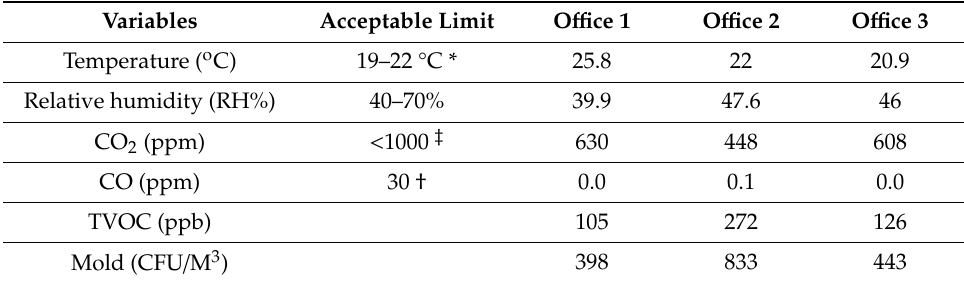
Table 4. Average measurement of indoor air quality in the selected o ffi ce